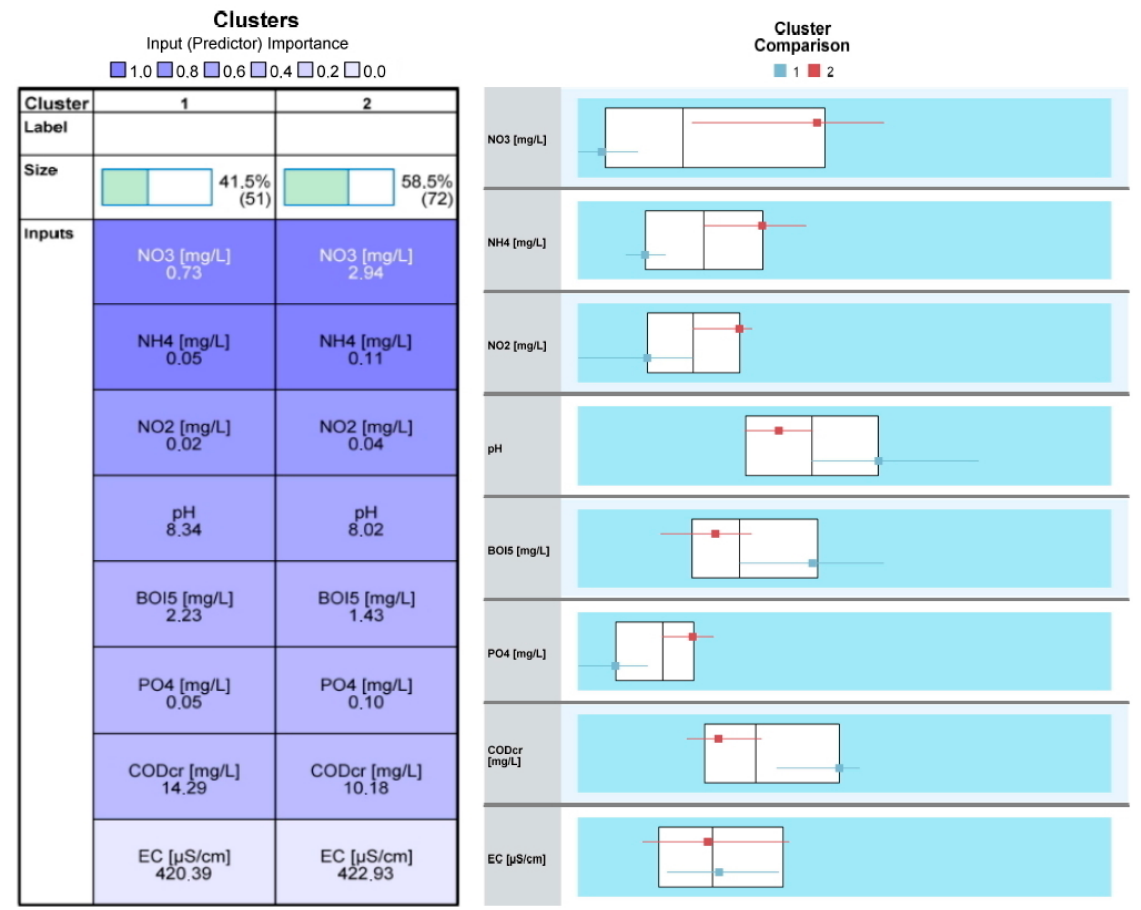
Figure 9. Dendrogram, representing the HCA results.